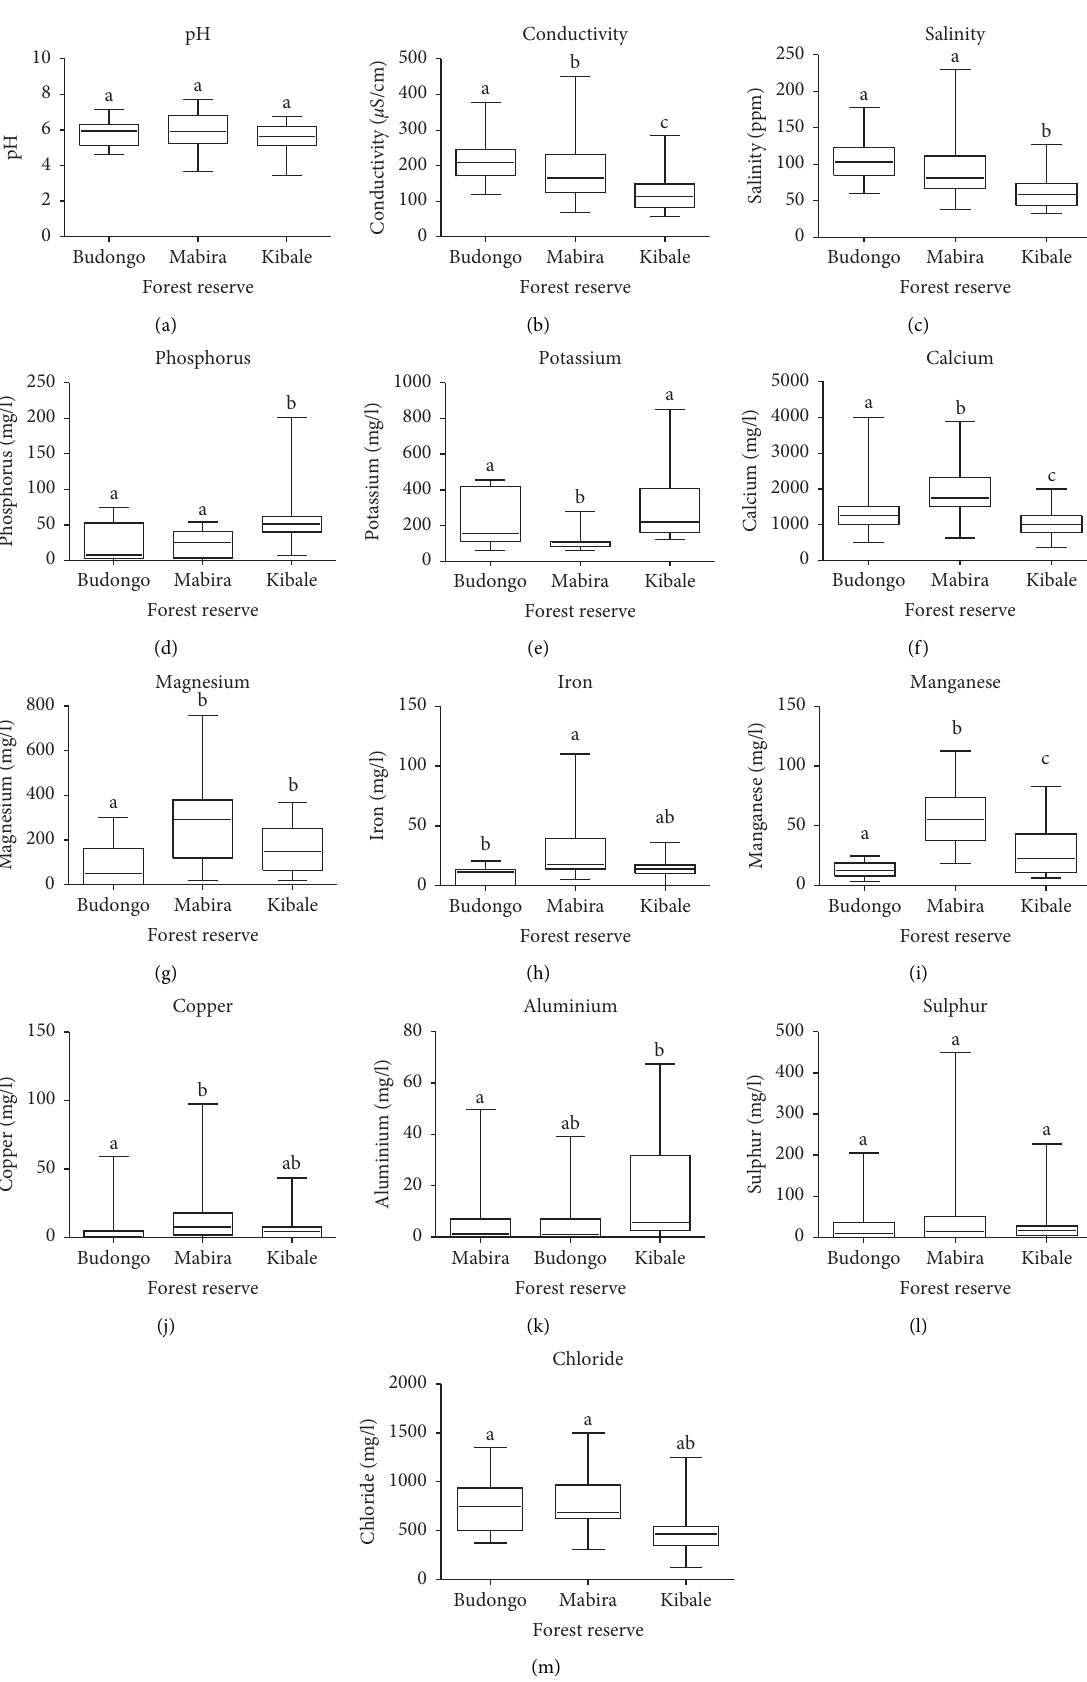
Figure 7: (a–m) Variation in the soil chemical parameters at site of occurrence of C. articulata in three forest reserves in Uganda. Box and whiskers with different lowercase letters indicate significant difference at p < 0 . 05 based on Dunn’s multiple comparison